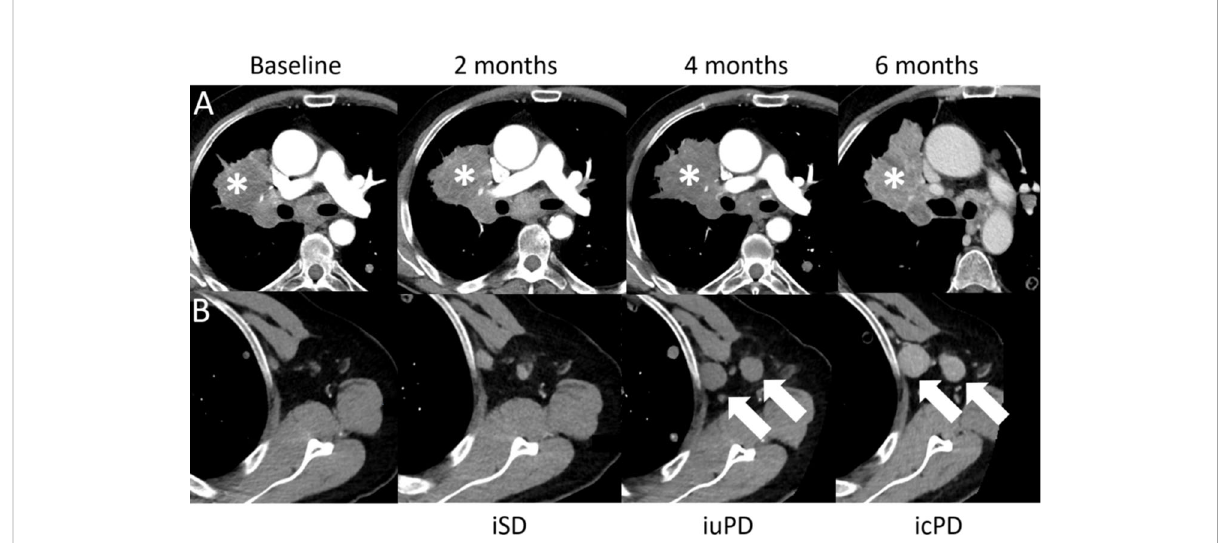
FIGURE 8 Con fi rmed progressive disease (icPD) in a 64-year-old male with right hilum adenocarcinoma treated with nivolumab (anti-PD-1) and anti- Lymphocyte Activation Gene-3 (LAG-3). Baseline contrast-enhanced CT demonstrates the right hilum mass ( A ,*). The 2-months follow-up showed stable disease (iSD). However, at the 4-months follow-up, the right hilum mass grew ( A ,*) and enlarged axillar lymph nodes appeared [ (B) , arrows], consistent with uncon fi rmed PD (iuPD). At the 6-months follow-up, con fi rmed PD (icPD) was established with continued growth of the right hilum mass ( A ,*) and the axillar lymph nodes [ (B) ,